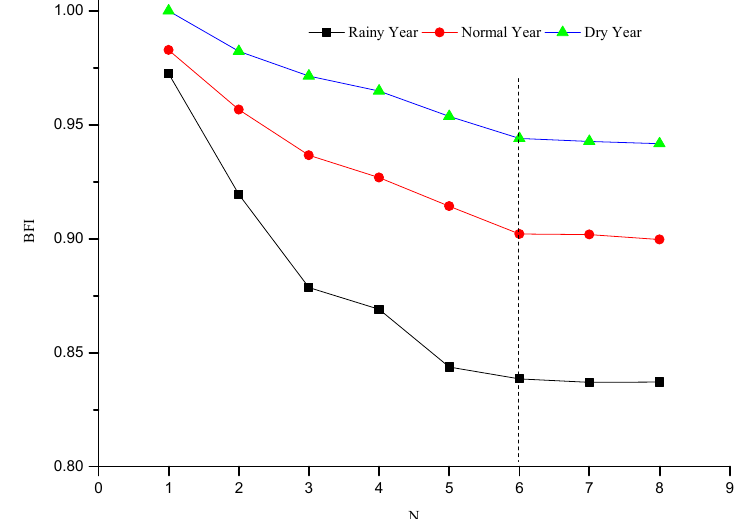
Figure 5. The baseflow index (BFI) value calculated by UK Institute of Hydrology’s method (UKIH) with different N for a rainy year, normal year, and dry year, respectively.